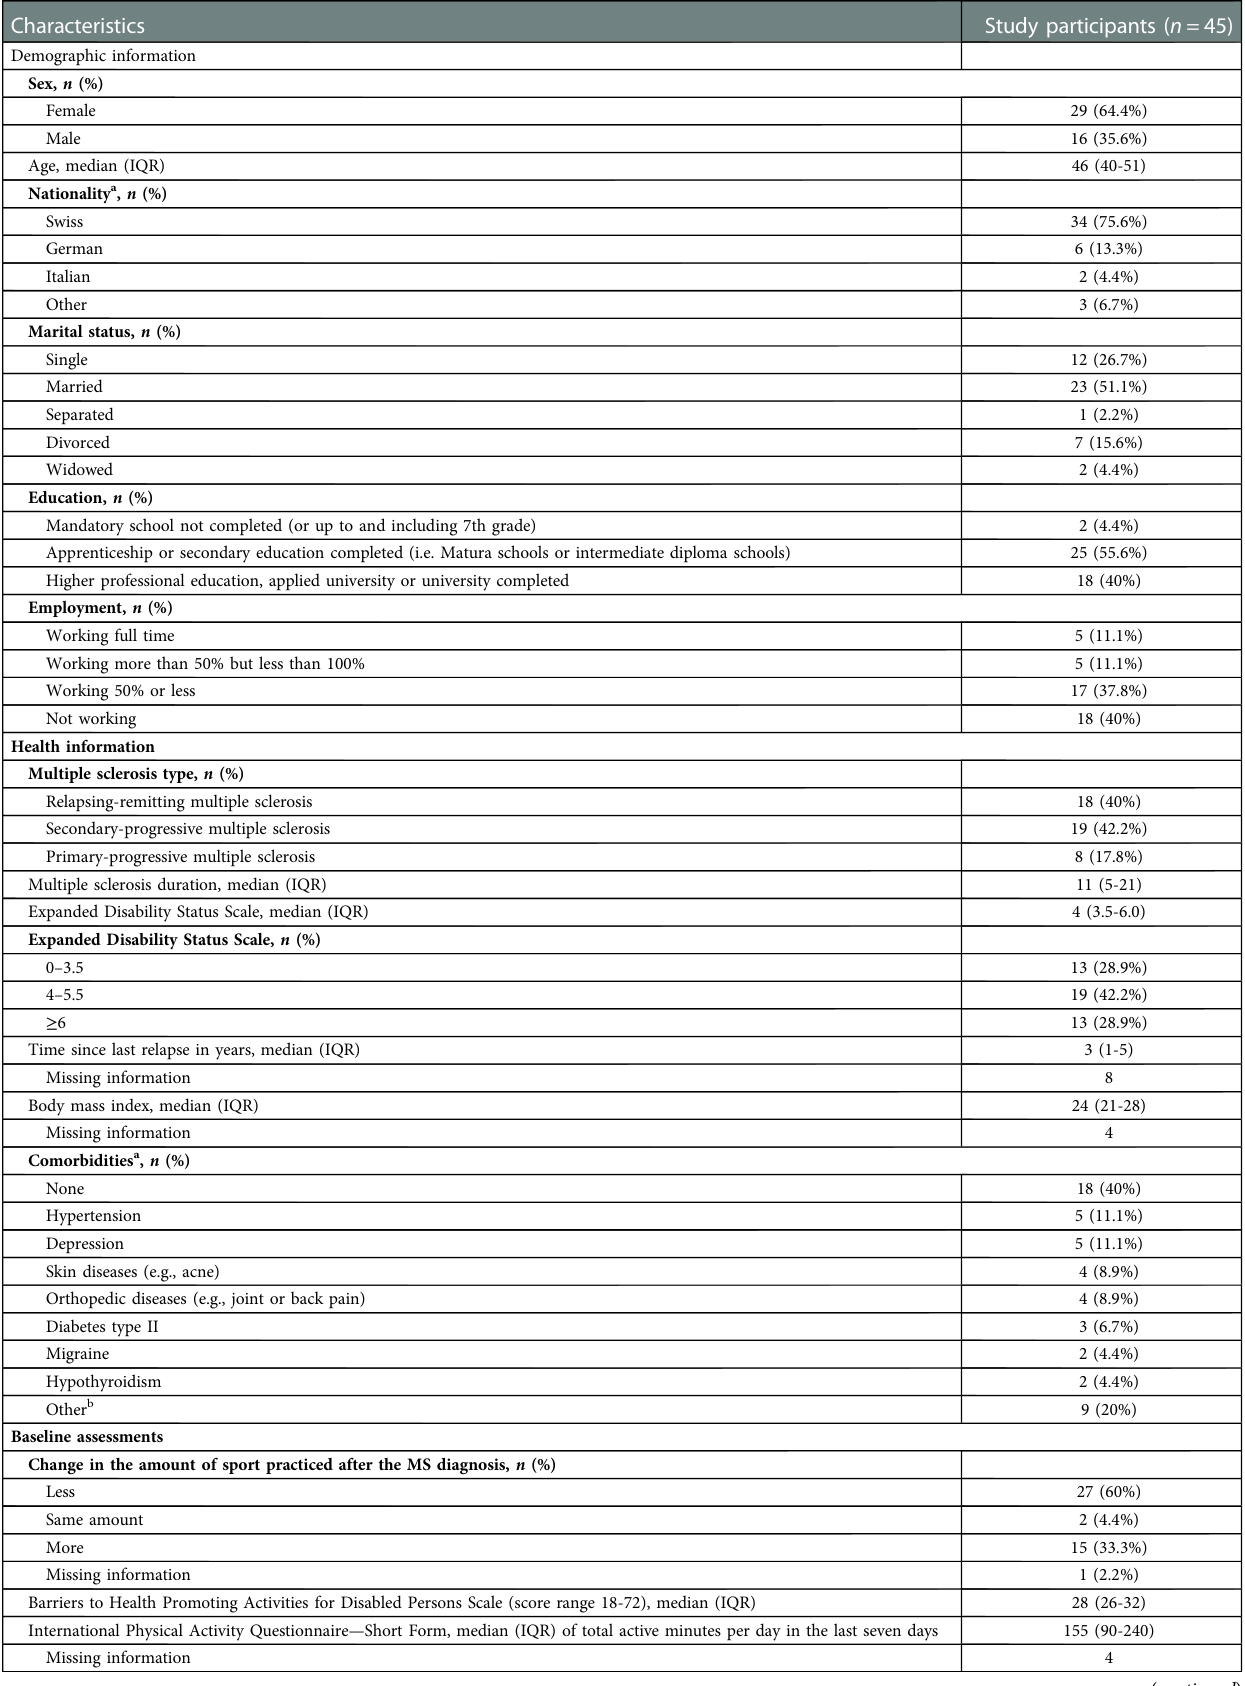
TABLE 2 Demographic and health characteristics, as well as baseline assessments of the study participants ( n